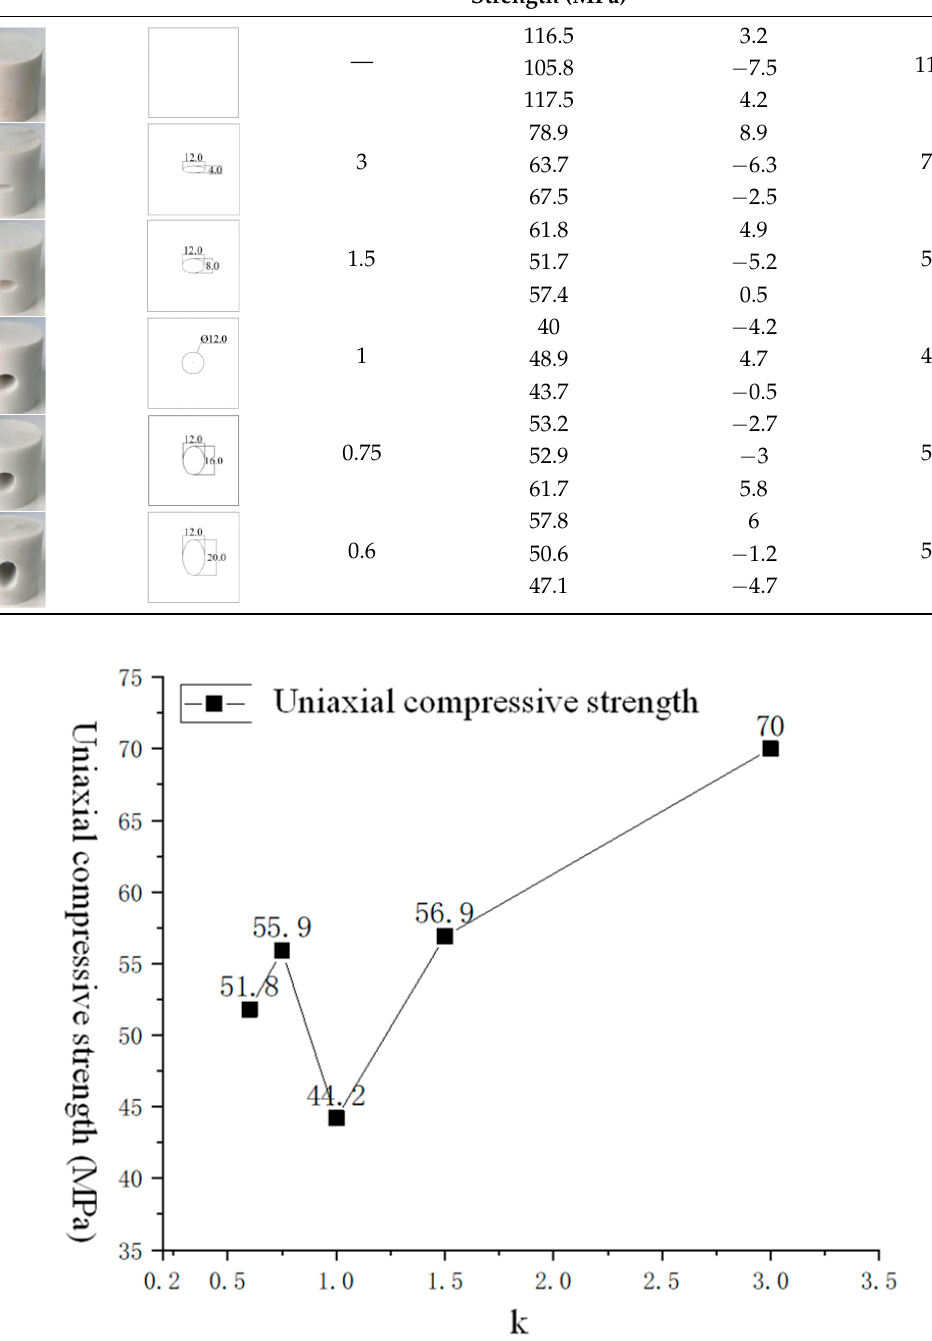
Table 1. Uniaxial compressive strength of all samples.